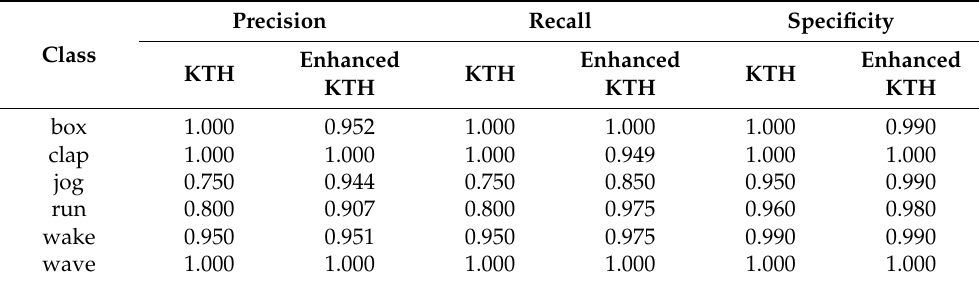
Table 5. Comparison of indicators before and after flipping enhancement of the KTH dataset.